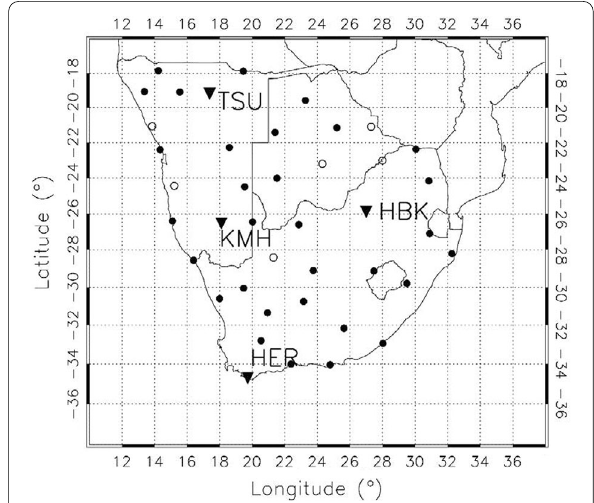
Fig. 1 Map showing the area of interest with four INTERMAGNET observatories in the southern African region (HER, HBK, TSU and KMH), represented by black triangles, and geomagnetic repeat stations that are represented by black dots and empty circles. The empty circles represent repeat stations with some outlier values; see text for details